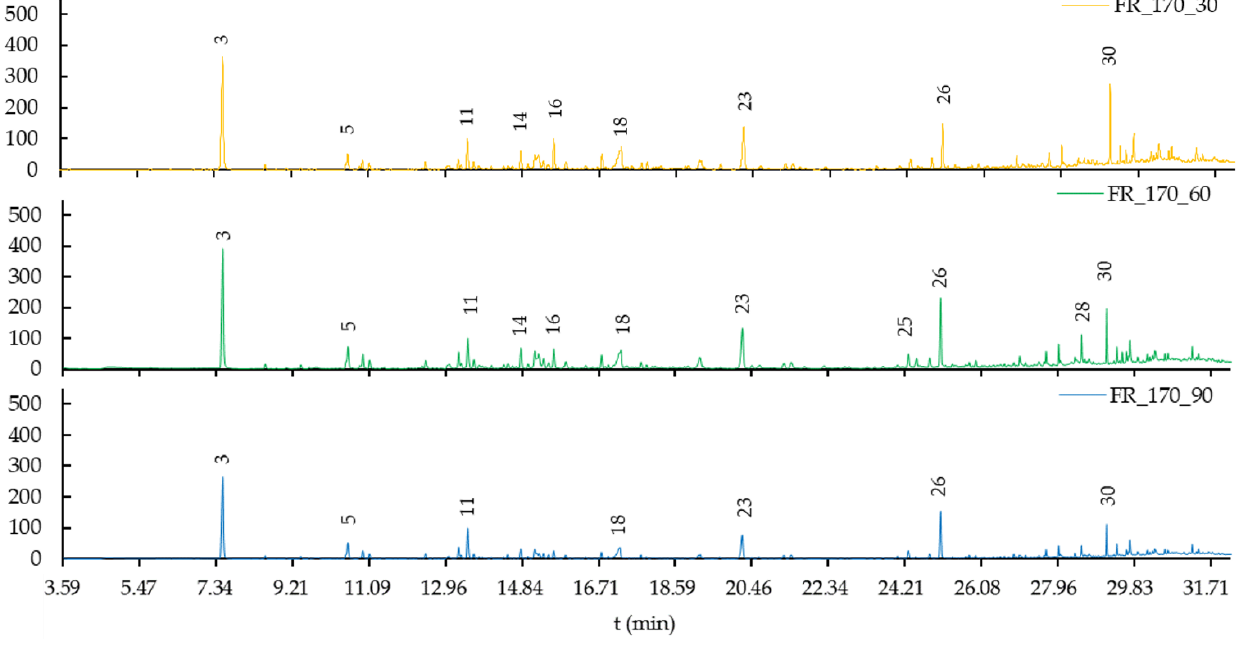
Figure 7. GC-MS diagram of the forest residue (FR) hydrothermally treated at 170 °C with 30, 60 and 90 min holding times, see peak numbers in Table 6.